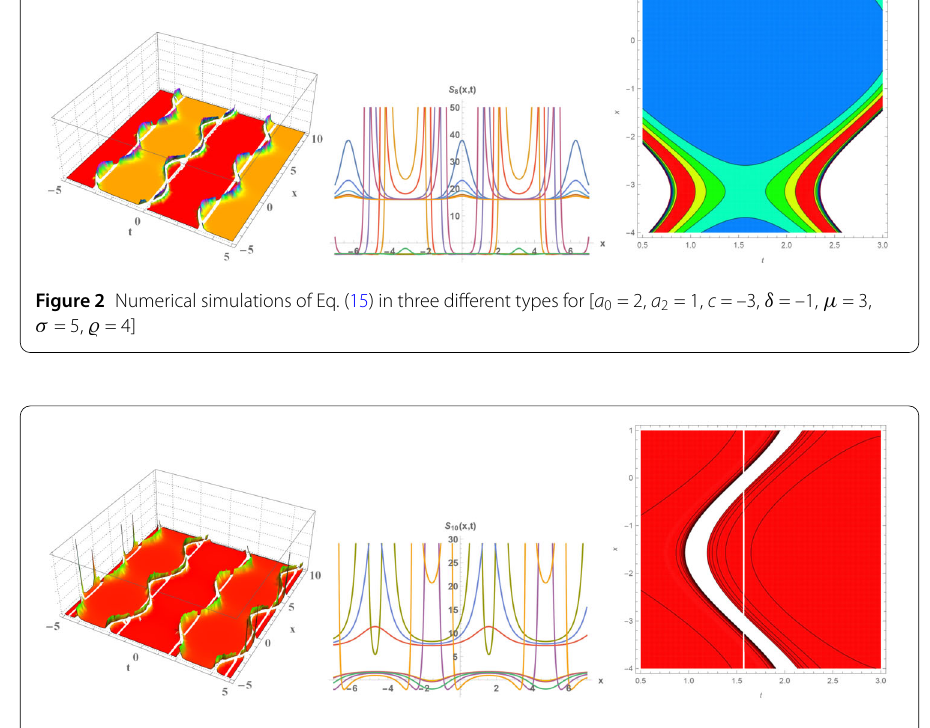
Figure 3 Numerical simulations of Eq. (17) in three different types [ a 0 = 2, a 2 = 1, c = –3, κ = –1, μ = 3, σ =